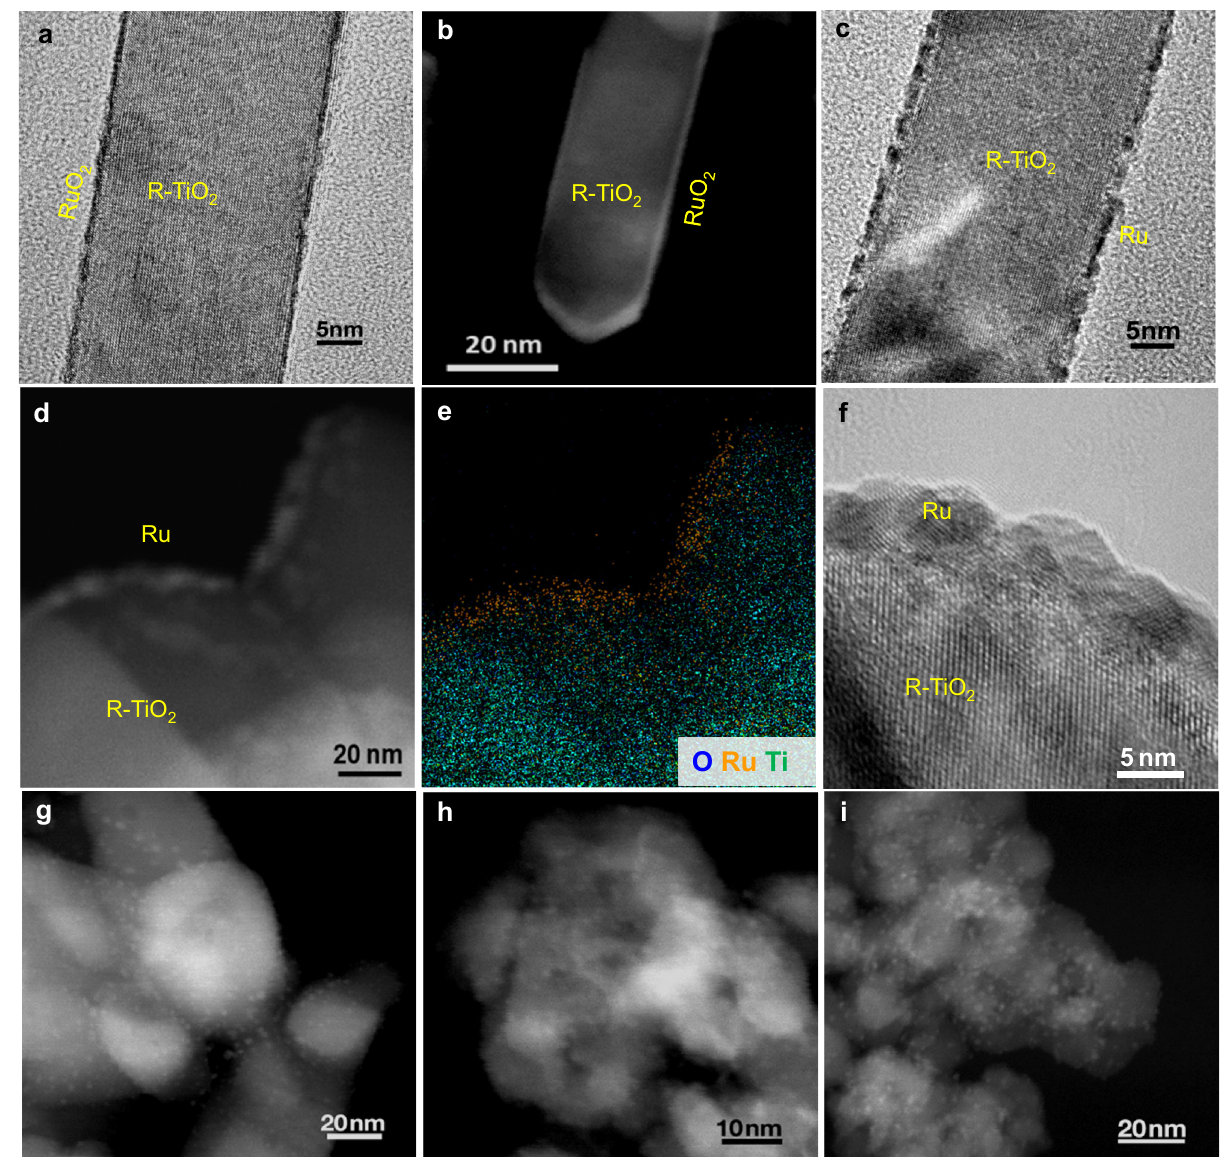
Fig. 2 Structure characterizations of Ru/TiO 2 catalysts. a TEM and b STEM images of RuO 2 overlayers on R – TiO 2 nanorods. c Ru/R – TiO 2 reduced from RuO 2 /R – TiO 2 by H 2 . d STEM, e elemental mapping, and f TEM images of Ru/R – TiO 2 – air – H 2 after CO 2 hydrogenation. STEM images of g Ru/R – TiO 2 – H 2 , h Ru/A – TiO 2 – air – H 2 , and i Ru/A – TiO 2 – H 2 after